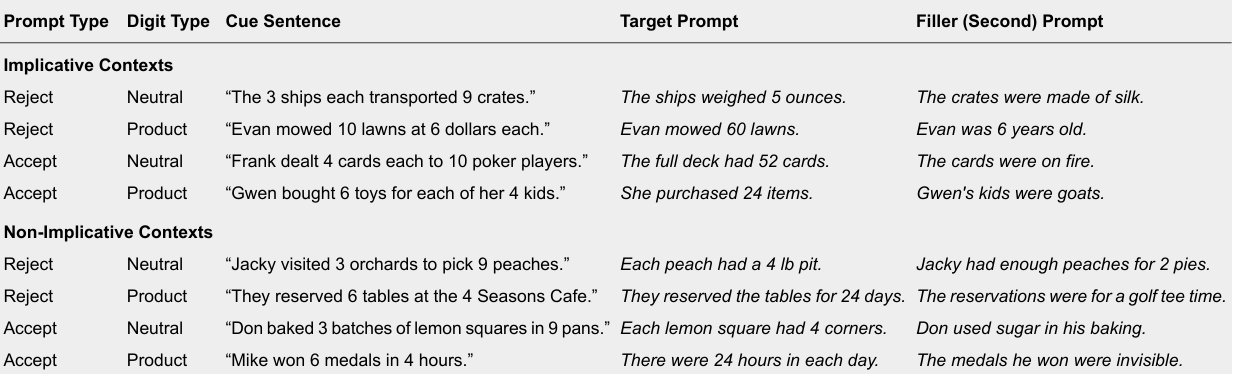
Example Stimuli for the Sentence Verification